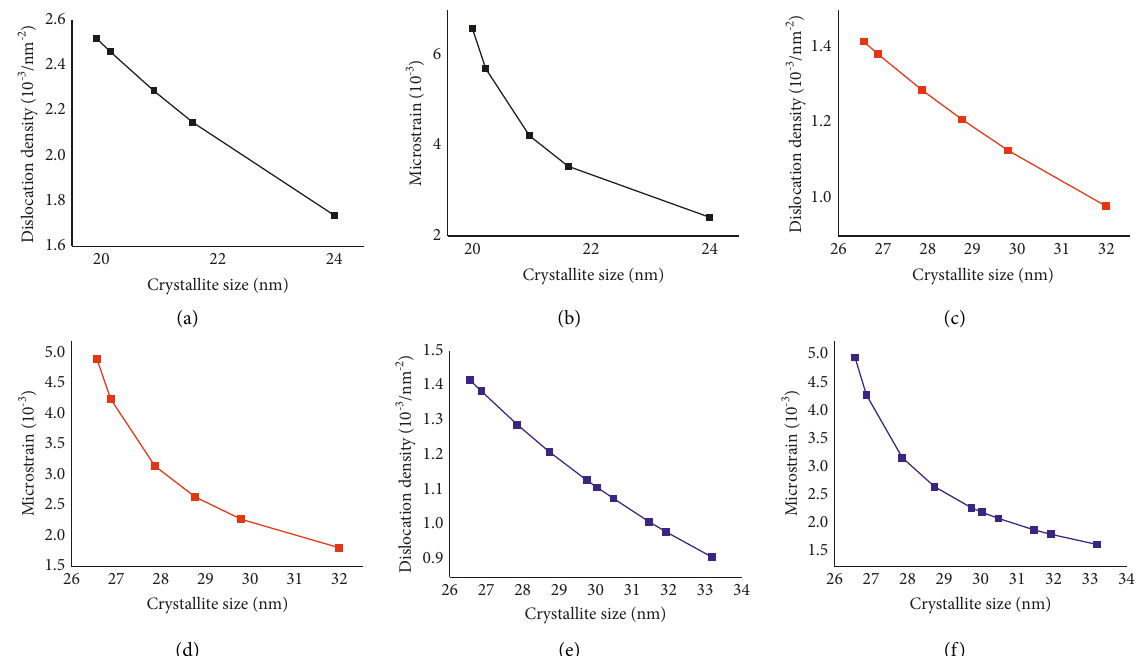
Figure 9: Variation of dislocation density and microstrain with crystallite size of NiS nanoparticles obtained from the solventless method at 200 ° C, 300 ° C, and 400 ° C.